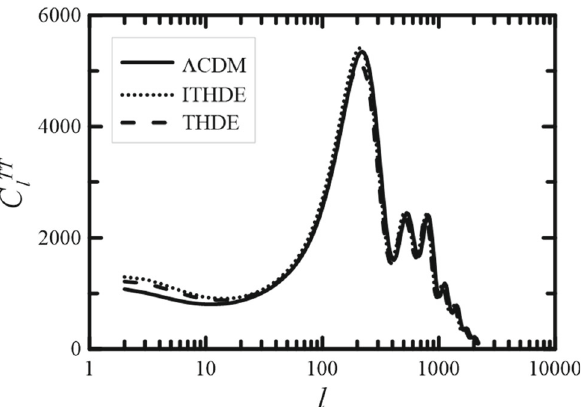
Fig. 9 The power spectrum of cosmic microwave background anisotropy of interacting and non-interacting THDE models with con- sideration of the future event horizon as IR cutoff compared to the (cid:2) CDM. The amplitud in small (cid:12) -poles for THDE is higher than the (cid:2) CDM model